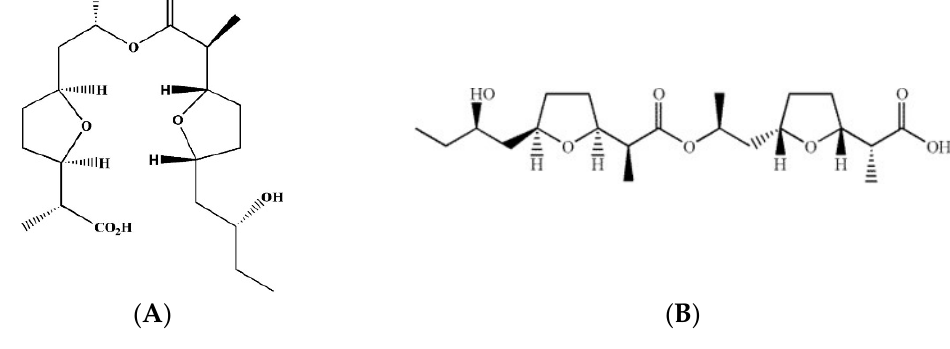
Figure 8. Structures of bonactin ( A ) and feigrisolide C ( B ).